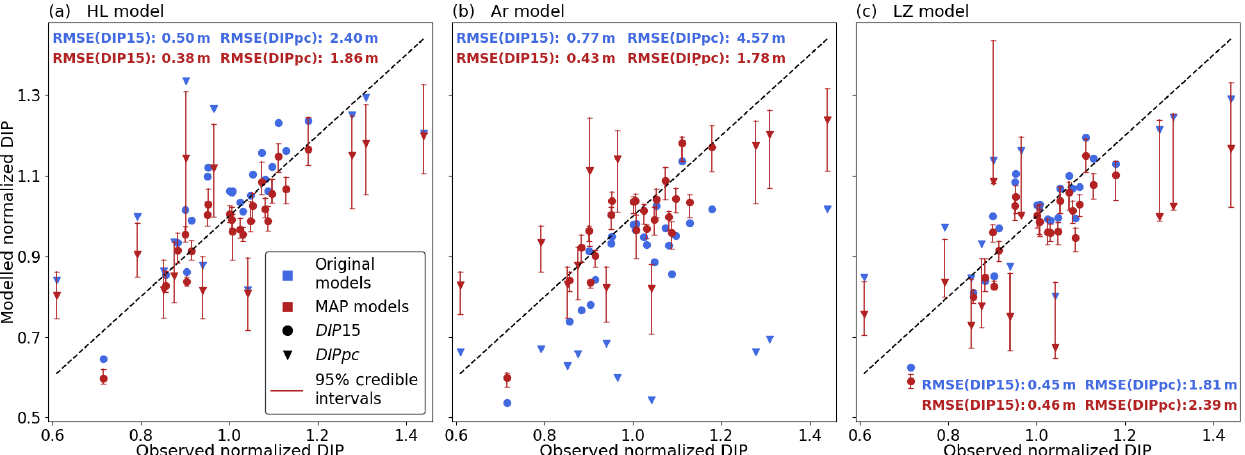
Figure 4. Comparison of evaluation data DIP with model results. The 95% credible intervals are computed from results of 500 randomly selected parameter combinations from the posterior ensembles of each model (HL, Ar, LZ). Similar scatter plots for the LZ dual and IMAU results are shown in the Supplement (Fig.